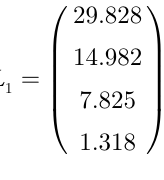
Here, for a given wetland i , x is the vector of four dimensions containing the values of the i variables: sqrt(exchangeable K + ), ln(exchangeable Mg 2+ ), sqrt(medium sand) and ln(Br). The vectors, L and constants C were as follows (outputs of the SAS procedure “DIS- g g CRIM”), where g = group: